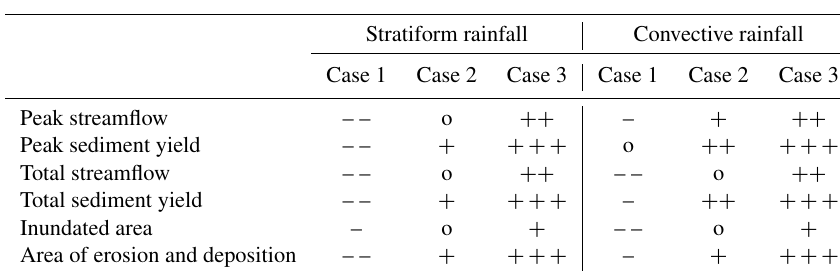
Table 5. A qualitative summary of the hydro-morphological response to the three main studied cases (Fig. 1) for the rainfall spatial structure corresponding to stratiform and convective types. For all three cases, the peak rainfall intensity at the grid scale intensifies. Case (1) total rainfall amount decreases, area of heavy rainfall decreases; case (2) total rainfall amount remains unchanged and area of heavy rainfall slightly decreases; case (3) total rainfall amount increases and area of heavy rainfall increases. The response varies between a strong negative response (– – –), no change (o), and a strong positive response ( +++